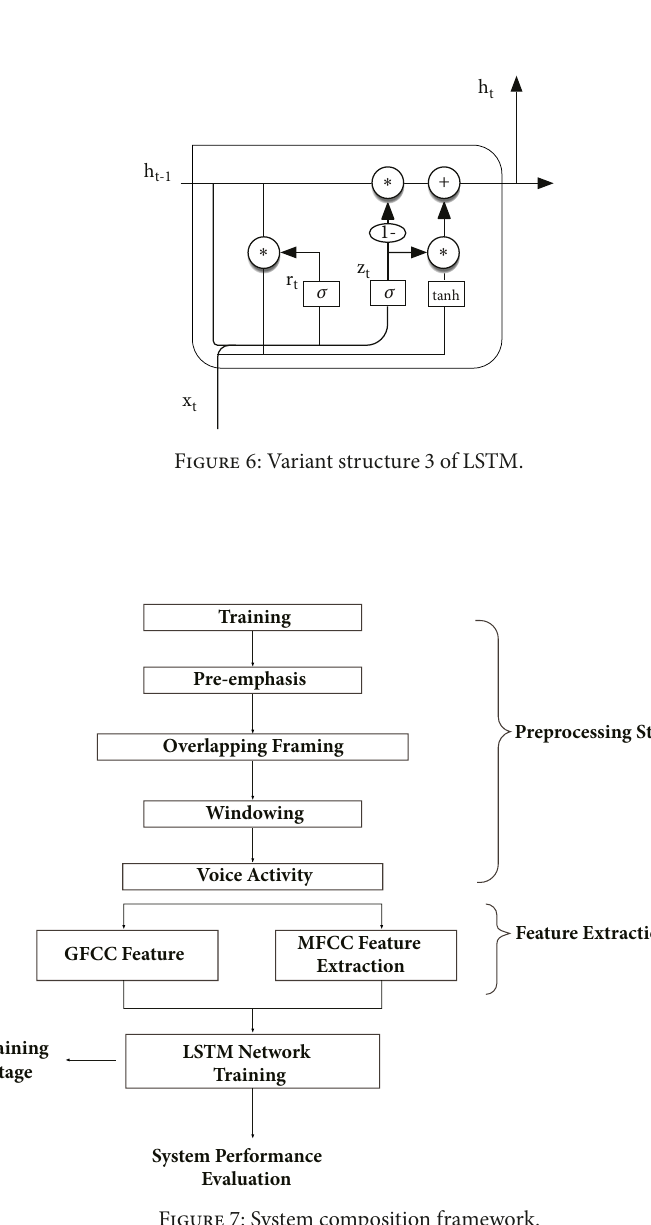
Figure 7: System composition